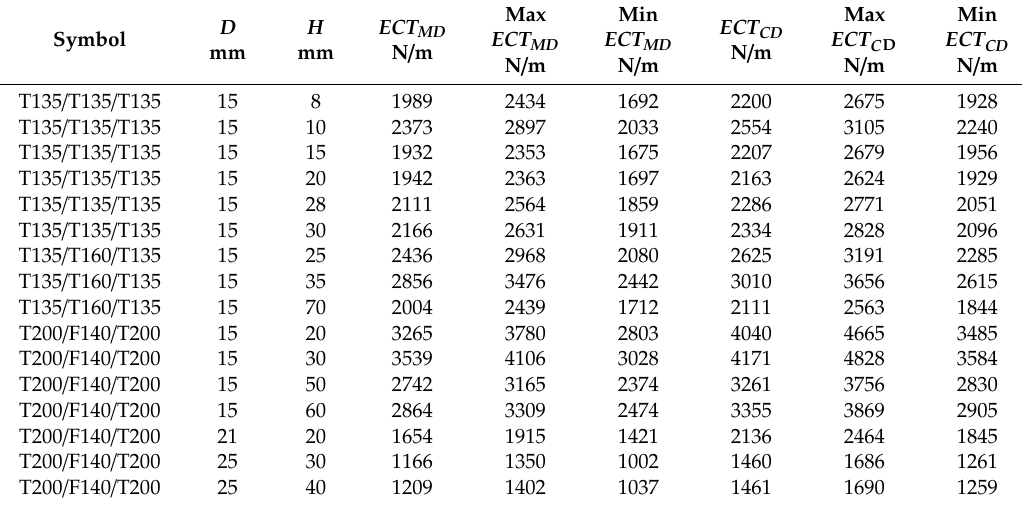
Table 3. ECT calculation results.